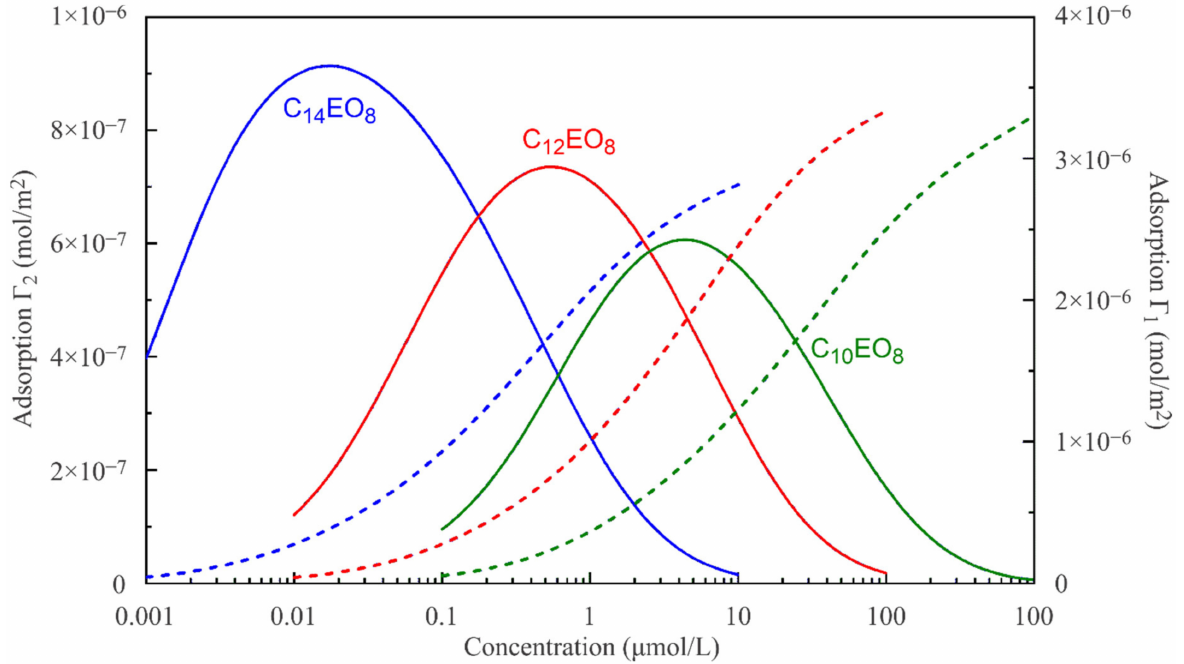
Figure 6. Adsorption in states 1 ( Γ 1 , dashed lined) and 2 ( Γ 2 , solid lines) of C 10 EO 8 (green lines), C 12 EO 8 (red lines) and C 14 EO 8 (blue lines) calculated according to the reorientation model with the parameter values presented in Table